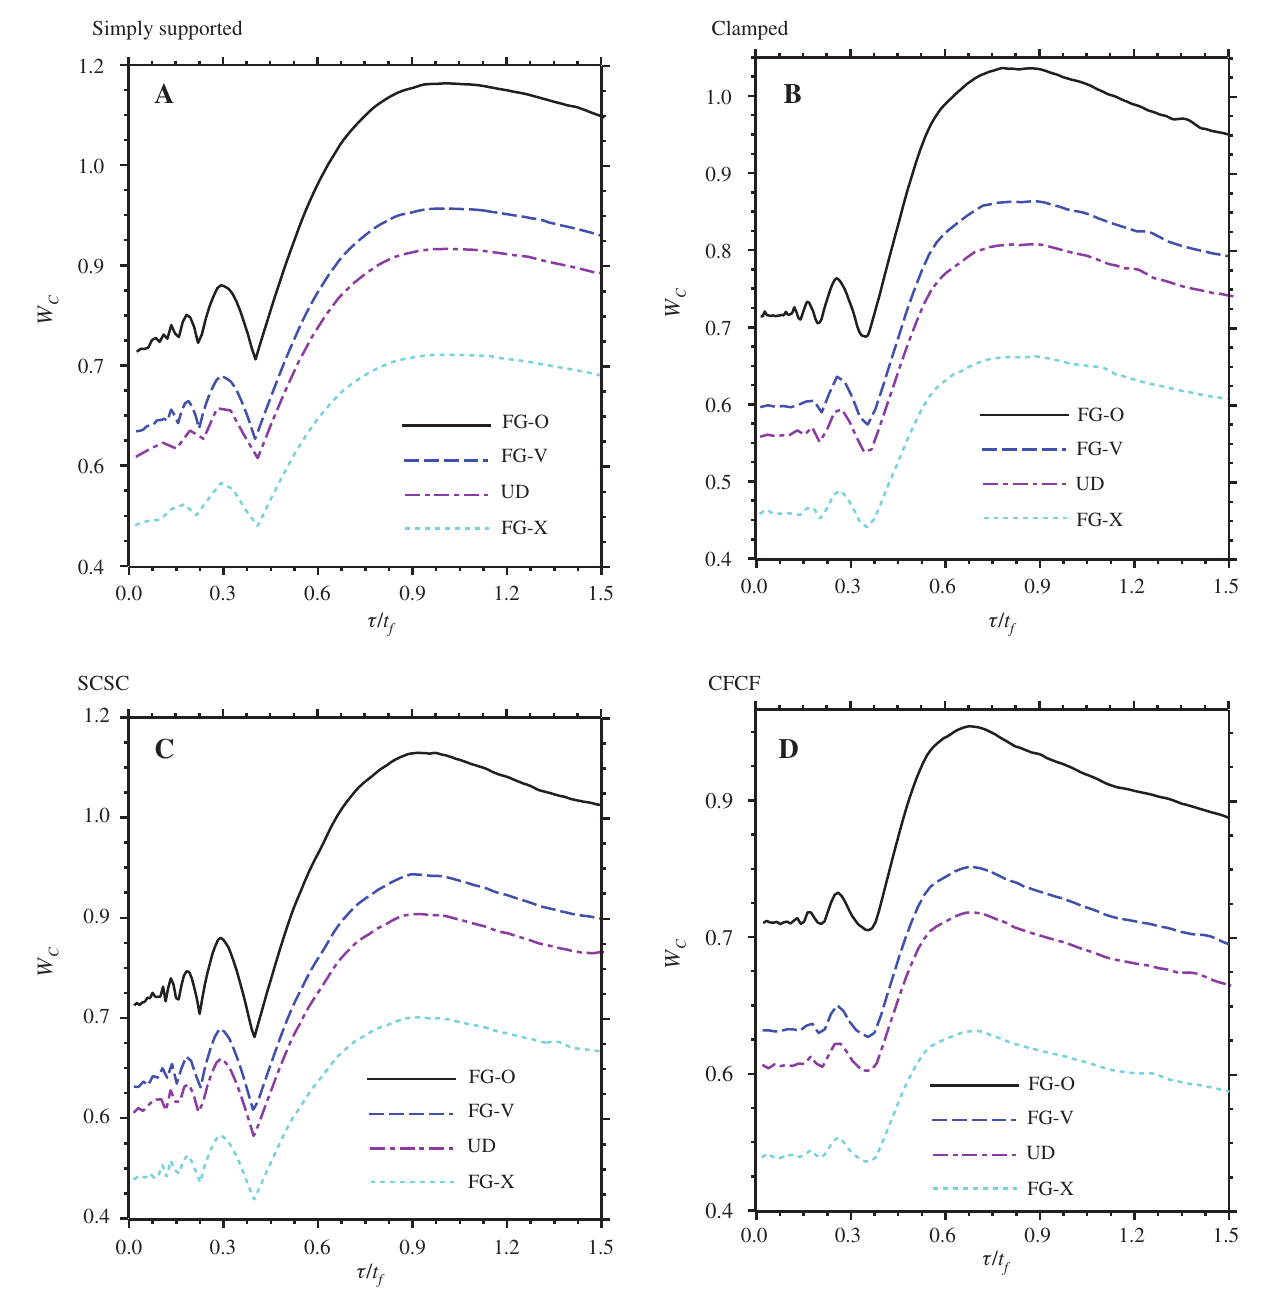
Figure 7 (A–D) The influence of three different CNT distributions on the dynamic behavior of CNTRC plates subjected to different boundary